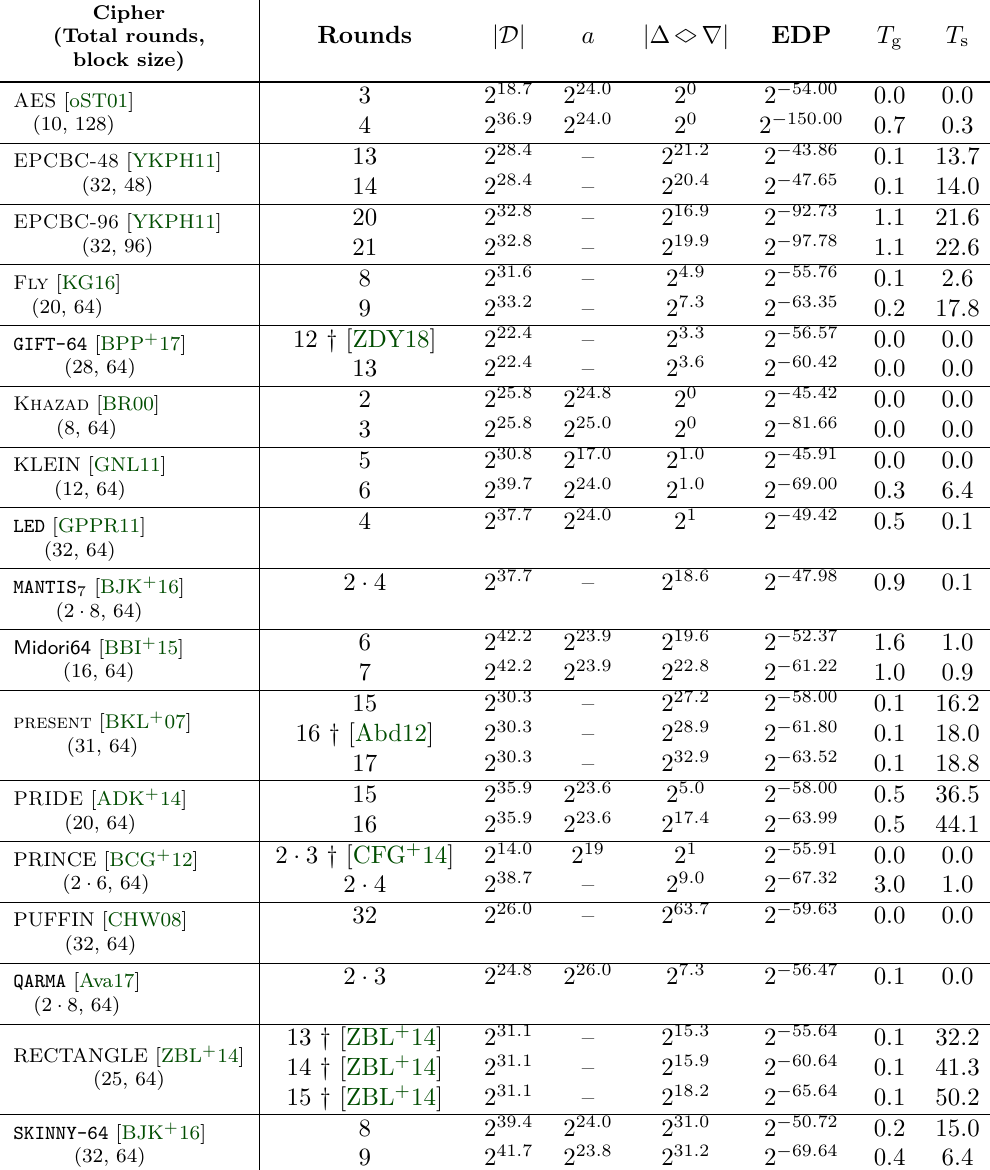
Table 2: Result for differential cryptanalysis obtained using the algorithm presented in this work. D is the set of single round differentials considered, a is the number of anchor vertices used, ∆ ♦ ∇ is the set of trails found for the best differential, EDP is the expected differential probability for the best differential, and T g and T s is the time in hours to generate and search through the graph, respectively. Entries annotated by † indicates an improvement over a previously published